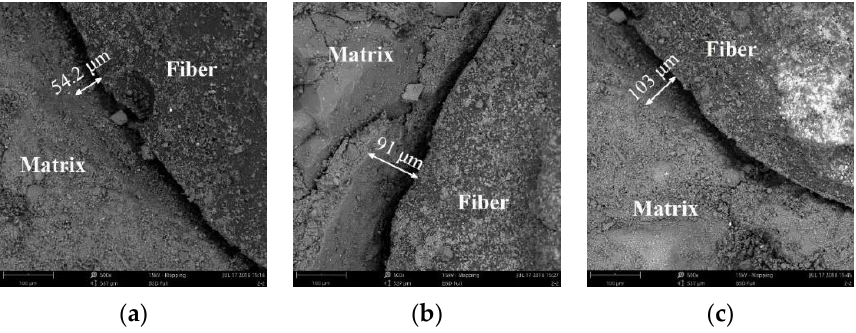
Figure 12. Annular crack width of specimens (water–cement ratio 0.45); ( a ) Tex content 9.2 k; ( b ) Tex content 18.4 k; and ( c ) Tex content 27.6 k.